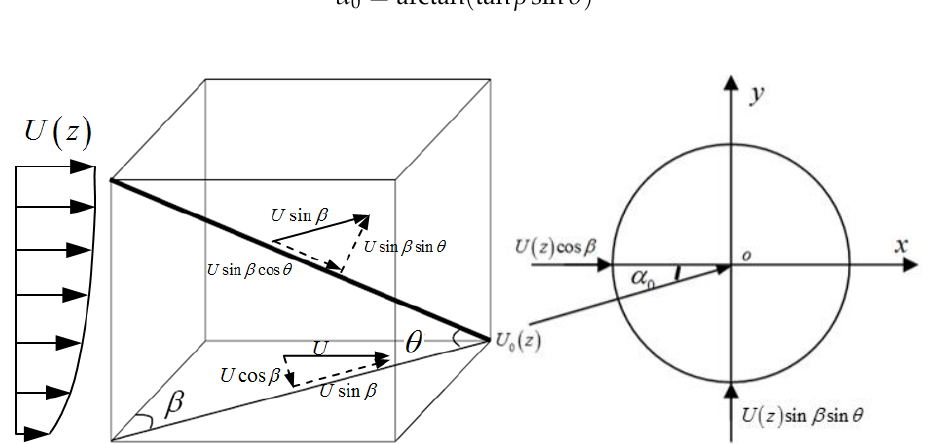
Figure 15. Schematic diagram of the inclination angle and wind yaw angle of the cable model.